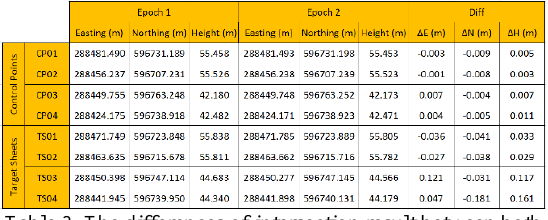
Figure 17. The observation of total station using intersection method from two observation stations at research area